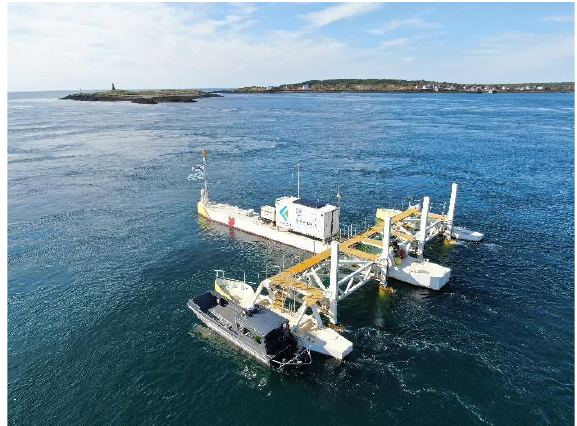
Fig. 1 PLAT-I 4.63 in operation as deployed in Grand Passage, Nova Scotia